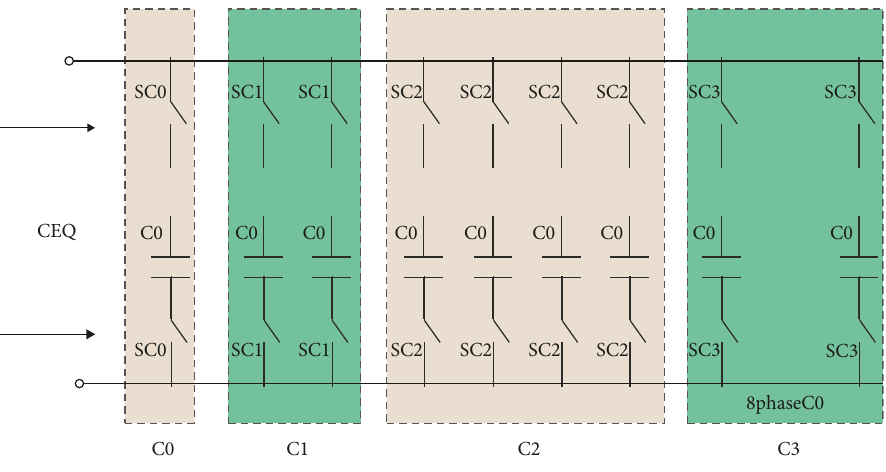
Figure 2: Programmable capacitor